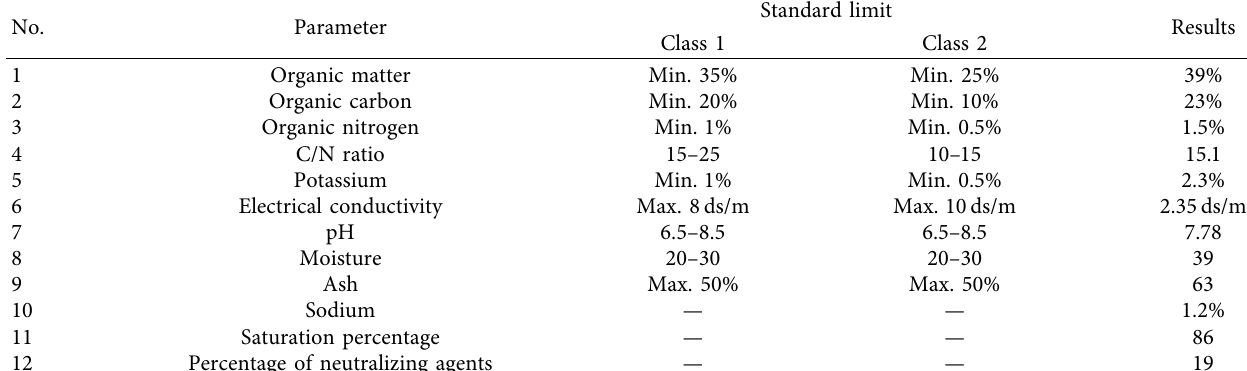
Table 1: Te physicochemical analysis of the vermicompost.